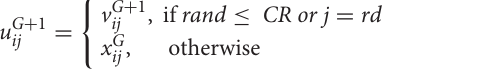
Frontiers in Materials |